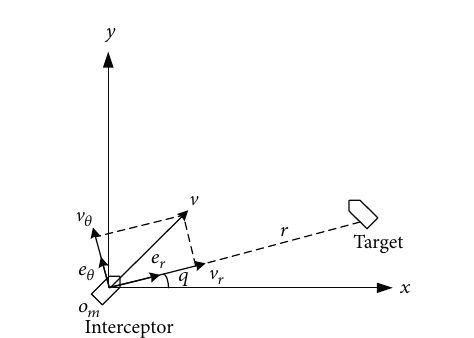
Figure 2: The intersection plane of interception